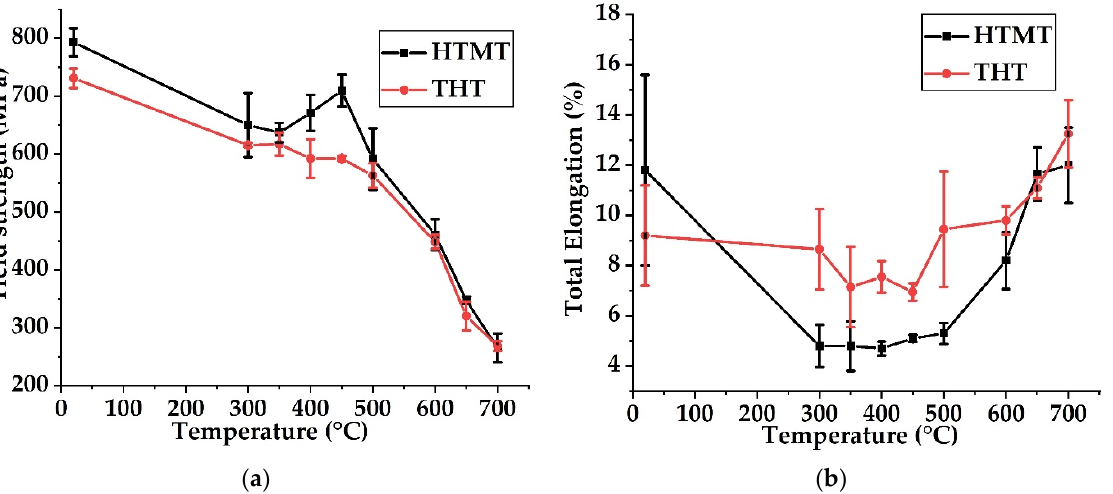
Figure 6. Variation of mechanical properties of EP-823 steel with temperature for THT and HTMT. Yield strength ( a ), total elongation ( b ).